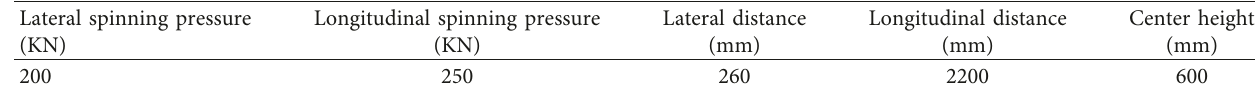
Table 9: Technical parameters of the spinning